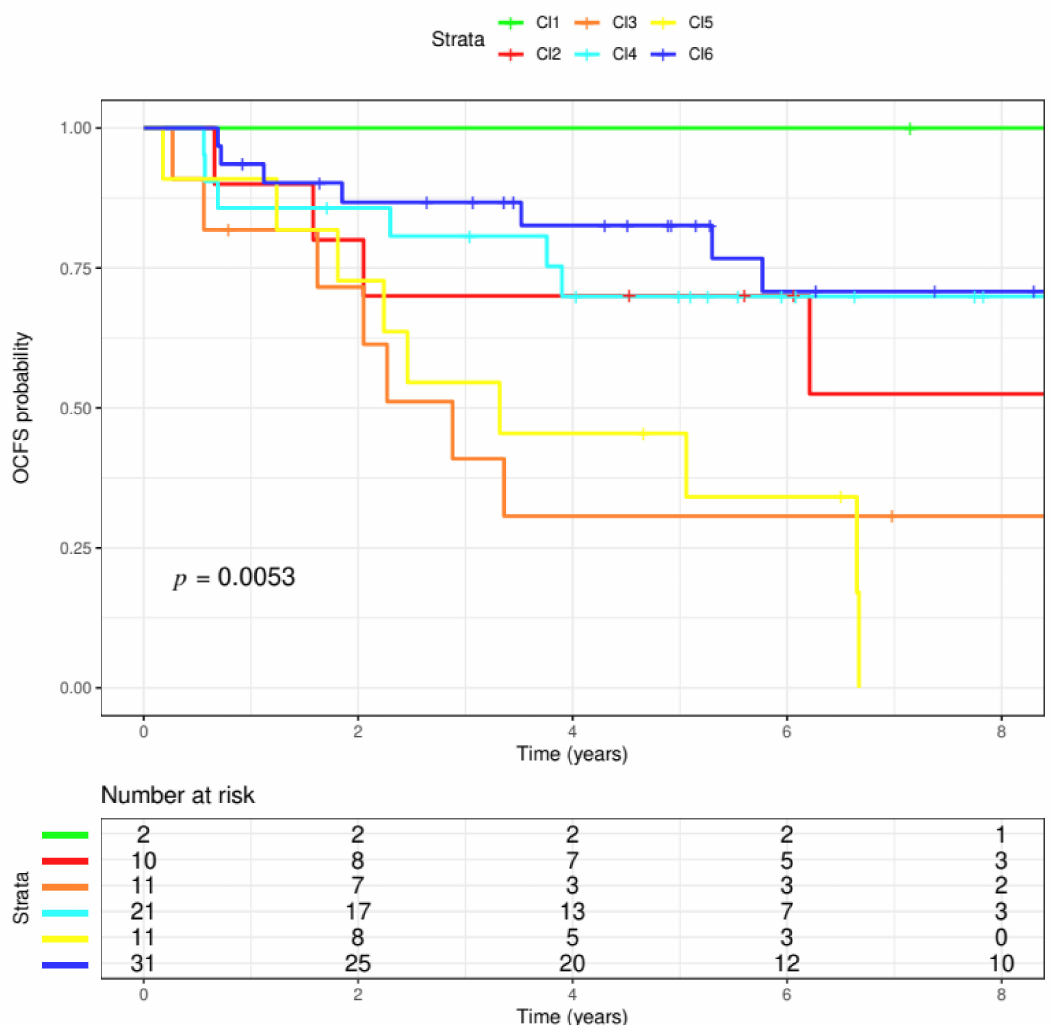
Figure 1. Six molecular subtypes. The six molecular HNSCC (head and neck squamous cell cancers) subtype classifications were applied to the OPL (oral premalignant lesions) dataset. The dataset included 86 patients, having a median follow-up of 6.08 years. The six clusters evidenced di ff erences in terms of probability of oral cancer development ( p = 0.0053, log-rank test). In particular, three clusters appeared to have the highest probability to modify their OPL status to cancer (Cl2, red; Cl3, orange; Cl5, yellow). On the contrary, the lowest probability was observed in Cl1, Cl4, Cl6 (green, blue, light blue,